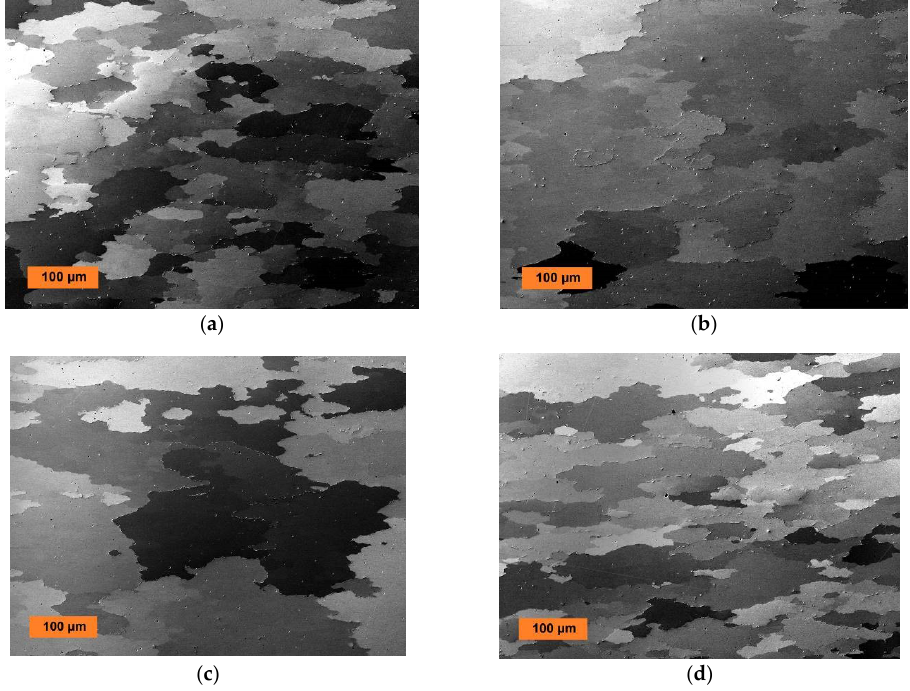
Figure 4. SEM micrograph (in BSE) of the coarse-grained microstructures of Fe-9Al-14Cr-4Y 2 O 3 new-generation ODS alloy after secondary recrystallization hot rolled at ( a ) 840 °C, ( b ) 900 °C, ( c ) 960 °C, and ( d ) 1020 °C.